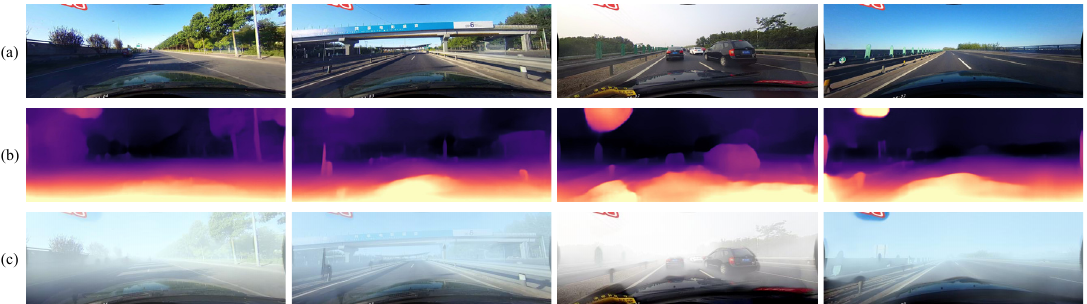
Figure 3. Examples of depth estimation and foggy image synthesis, ( a ) original images from CULane, ( b ) depth maps predicted by Monodepth2, and ( c ) synthetic foggy images.